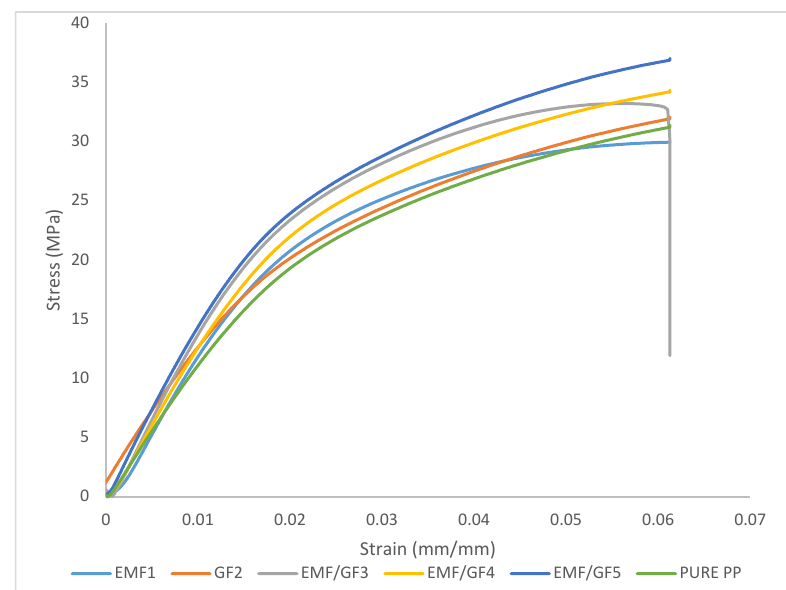
Figure 4. Stress–strain curve for the short Entada mannii -glass fiber hybrid composites.